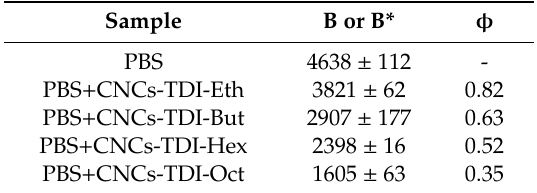
Figure 3. Nucleation activity determination for the neat and reinforced PBS using Dobreva and Gutzow’s method. Table 2. The estimated nucleation activity values for neat and reinforced PBS.